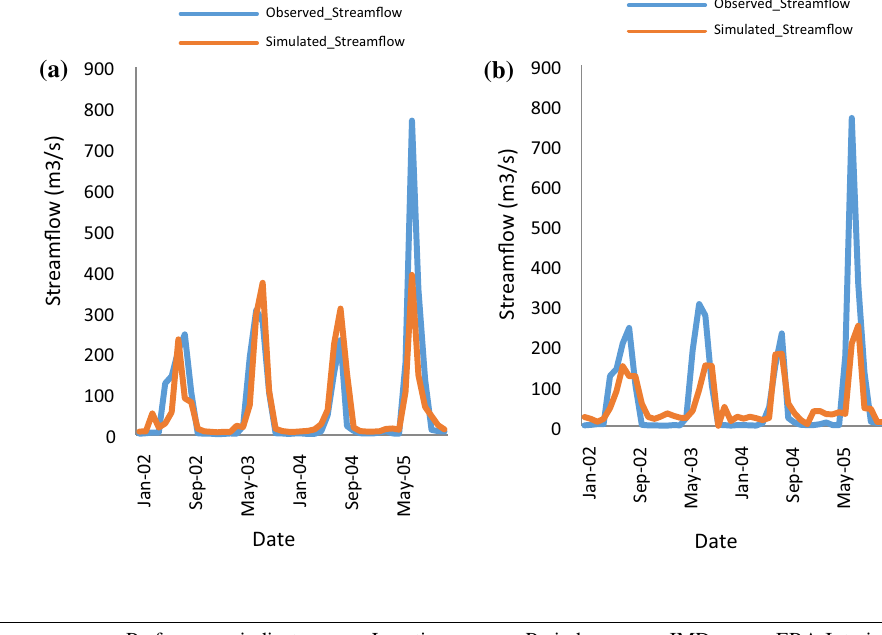
Table 4 Relative error (%), RMSE (m 3 /s), NSE and R 2 for simulated river